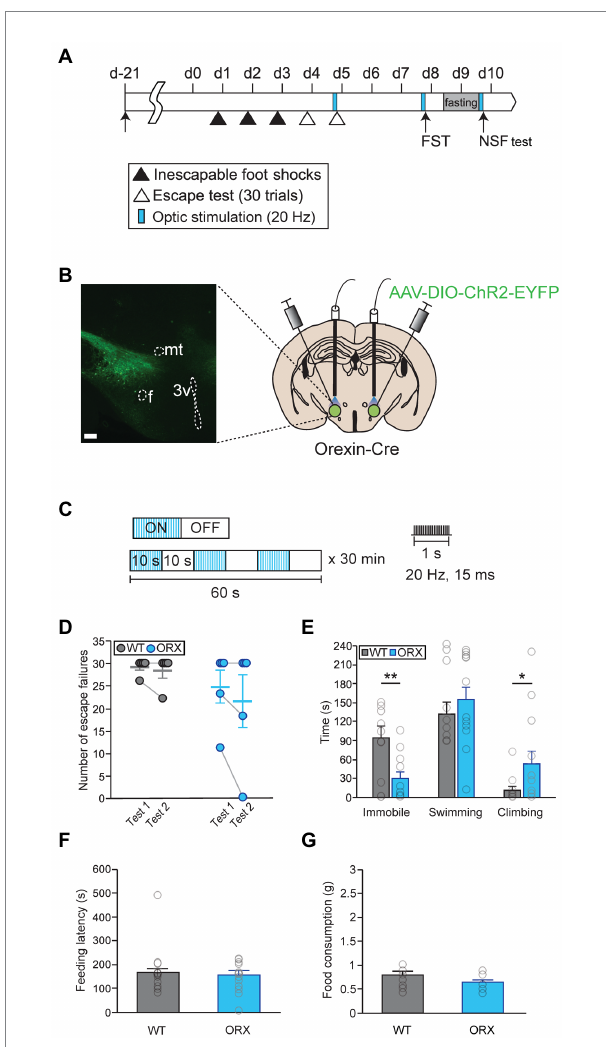
FIGURE 3 Optical photostimulation of lateral hypothalamic area (LHA) orexinergic neurons induces active coping behavior. (A) Experimental schedule of optogenetic activation of orexinergic neurons [WT, n = 11; orexinergic (ORX), n = 13]. (B) A representative image and diagram of the sites of virus injection and optical stimulation. f, fornix; 3v, third ventricle; mt, mammillothalamic tract (scale bar indicates 200 μ m). (C) The optical stimulation paradigm used in this study. (D) Optogenetic activation of orexinergic neurons (blue) failed to induce a significant change in stress resilience in the learned helplessness test (LHT). (E) Optical stimulation of orexinergic neurons had a significant antidepressant-like effect in terms of immobility and climbing behavior in the FST (** p < 0.01, * p < 0.05, Mann–Whitney U post hoc test). (F, G) Optical stimulation of orexinergic neurons did not induce a change in feeding latency or total food consumption in the novelty suppressed feeding (NSF)